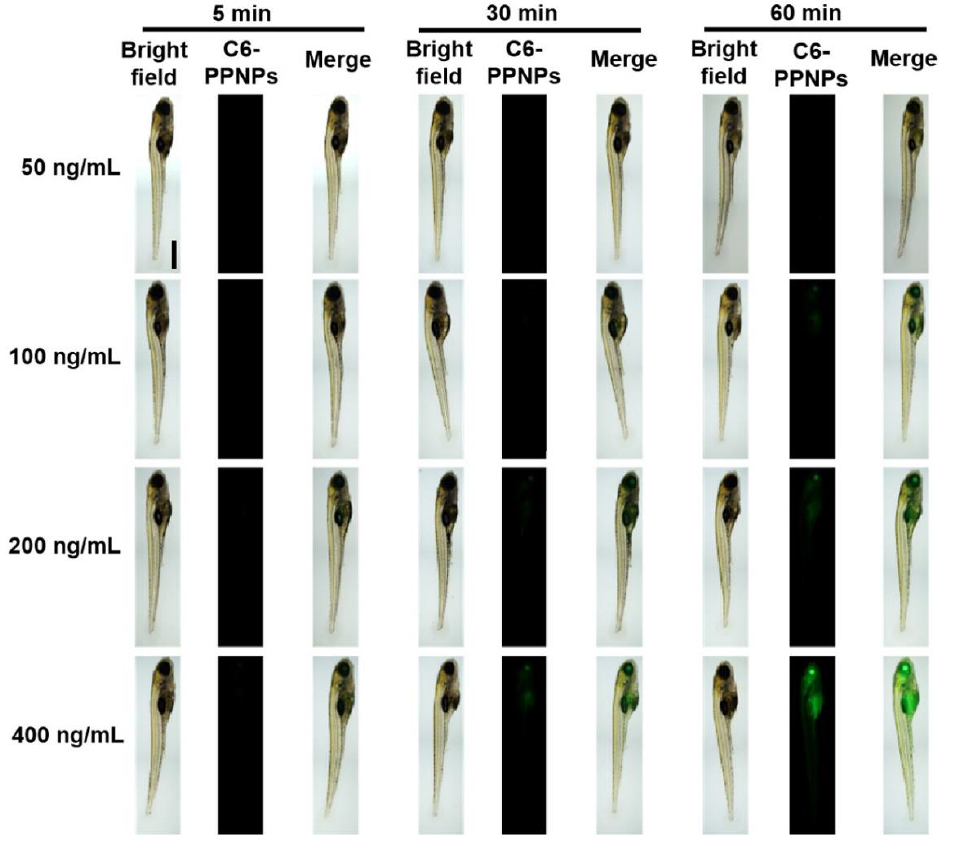
Figure 4. Imaging of zebrafish larvae. Zebrafish embryos (7 hpf) following incubation with C6-PPNPs at C6 concentrations of 50, 100, 200, and 400 ng/mL for 5, 30, and 60 min. Scale bar: 500 μm.